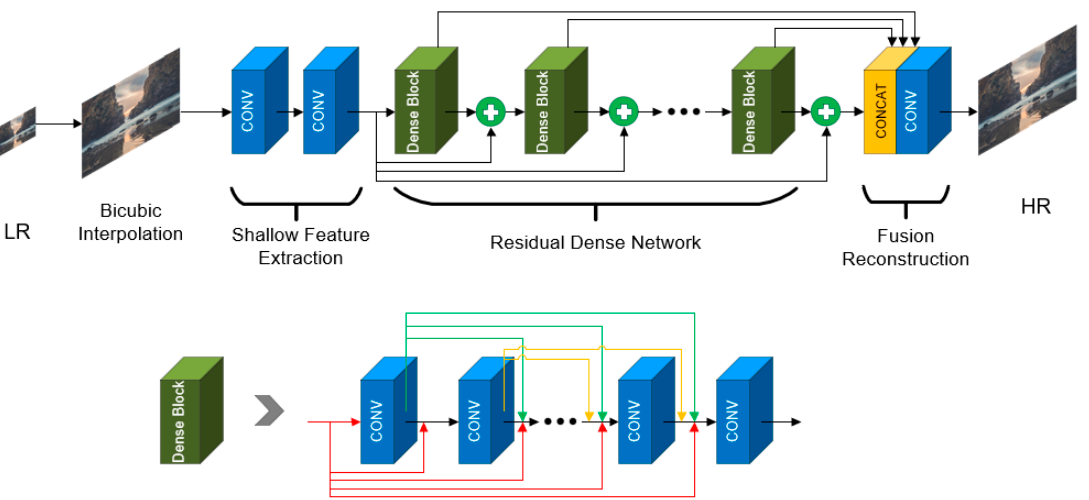
Figure 14. DRDN network structure.